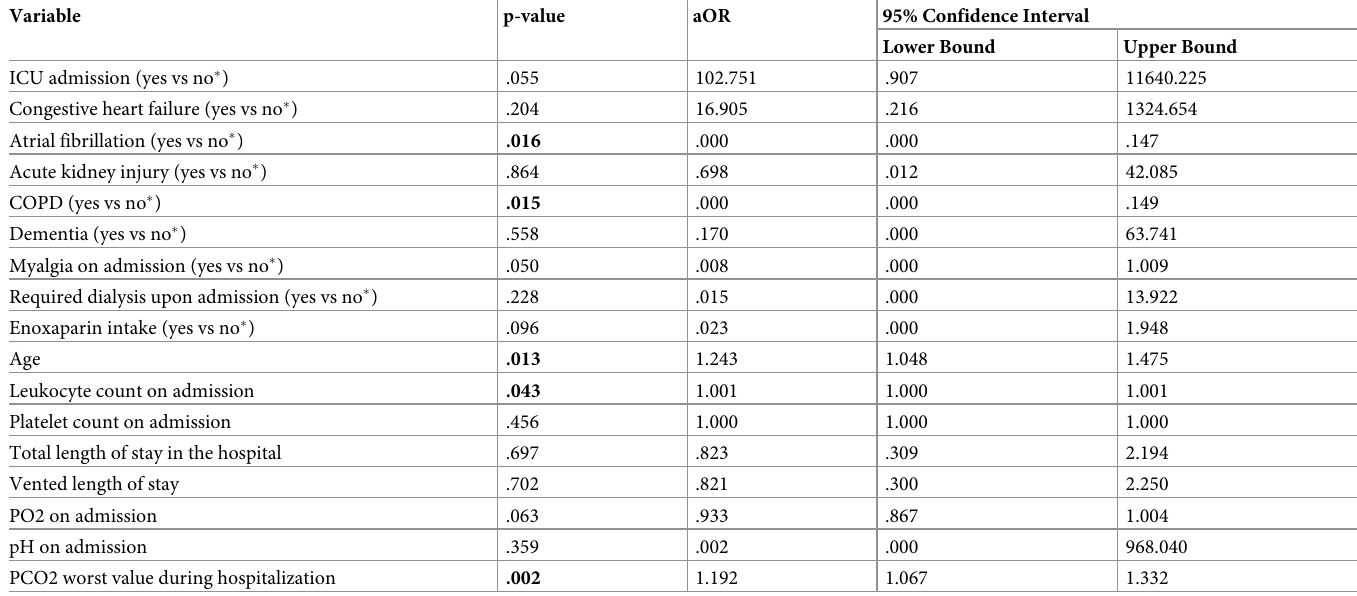
Table 4. Multivariable analysis: Logistic regression taking the presence vs absence of death as the dependent variable and all variables that showed significance in the bivariate analysis as independent ones (N = 88).